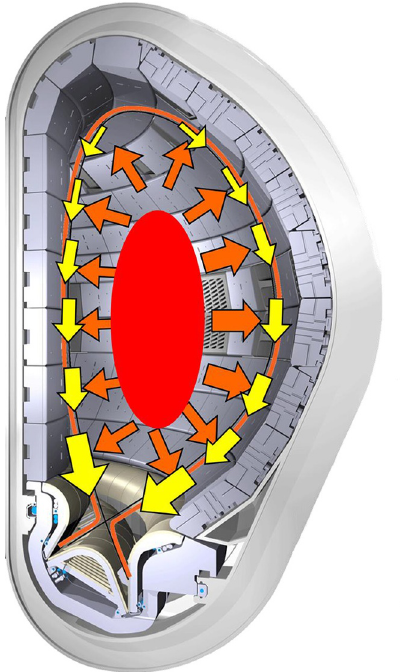
Fig. 4. – Divertor geometry. The orange line is the magnetic